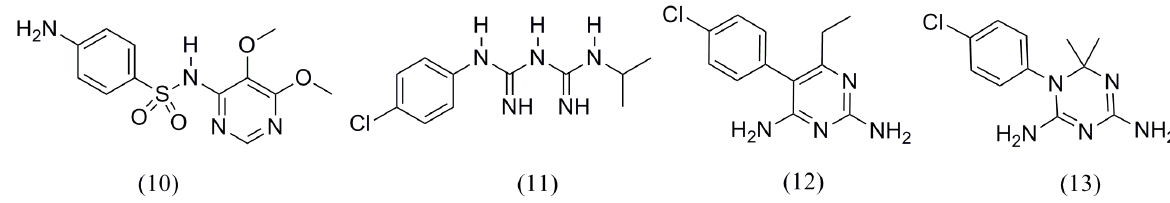
Figure 3 - Antifolates used in the treatment of